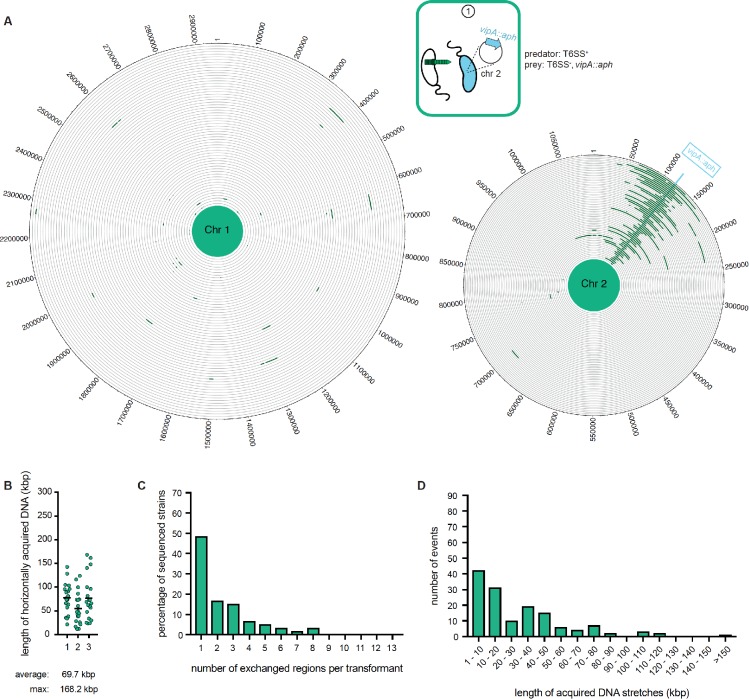
WGS-based quantification of horizontally acquired DNA under condition ①.Data as in Figure 3 with the addition of the map of both chromosomes in panel A.